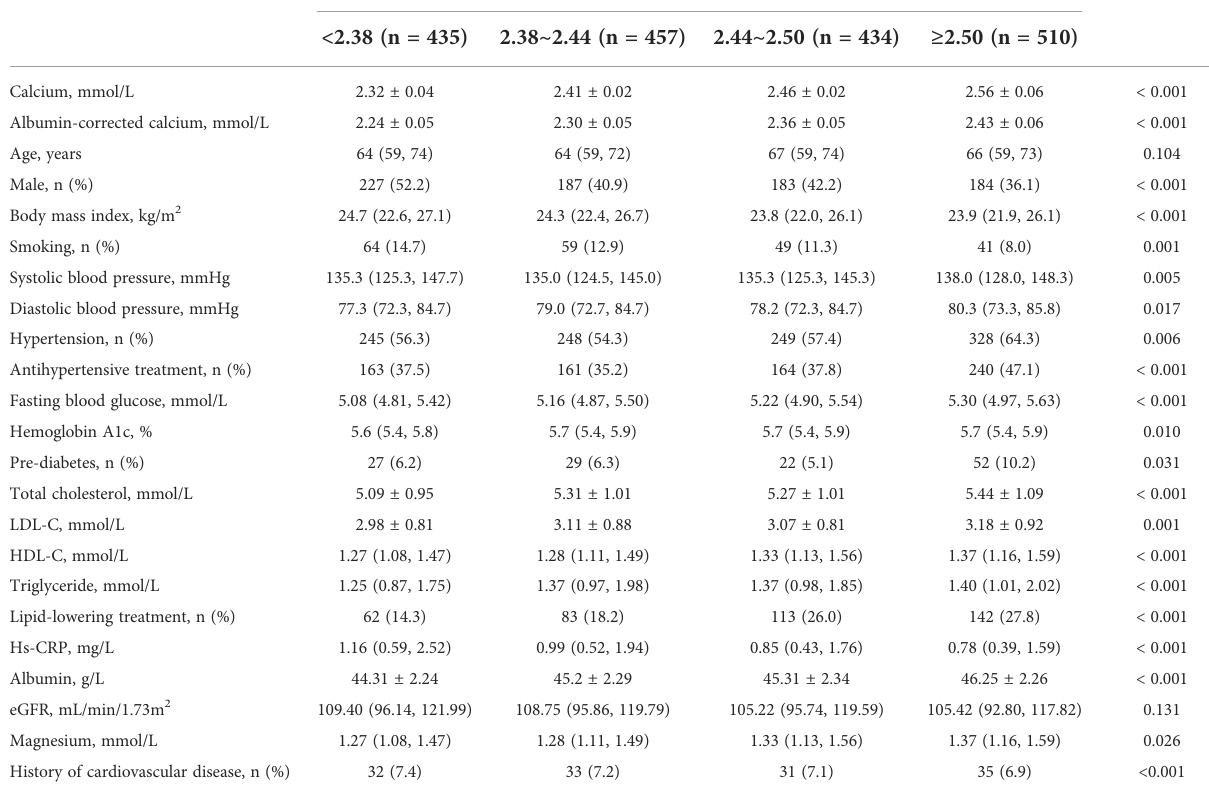
TABLE 1 The characteristics of participants across the quartiles of serum